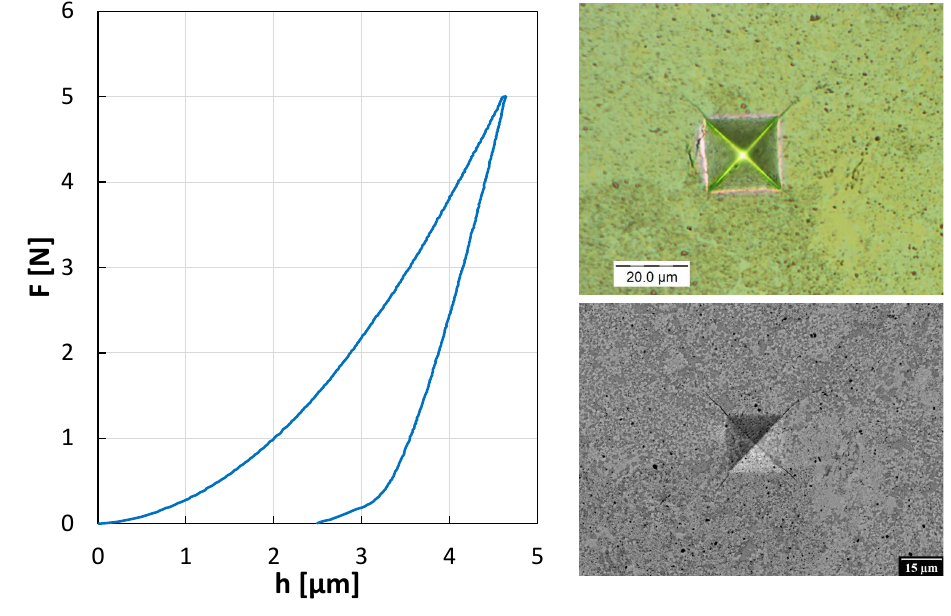
Figure 3. Indentation curve and the residual indent with Palmqvist and lateral cracks in FeAl_Si sample. Lateral cracks are visible on light optical